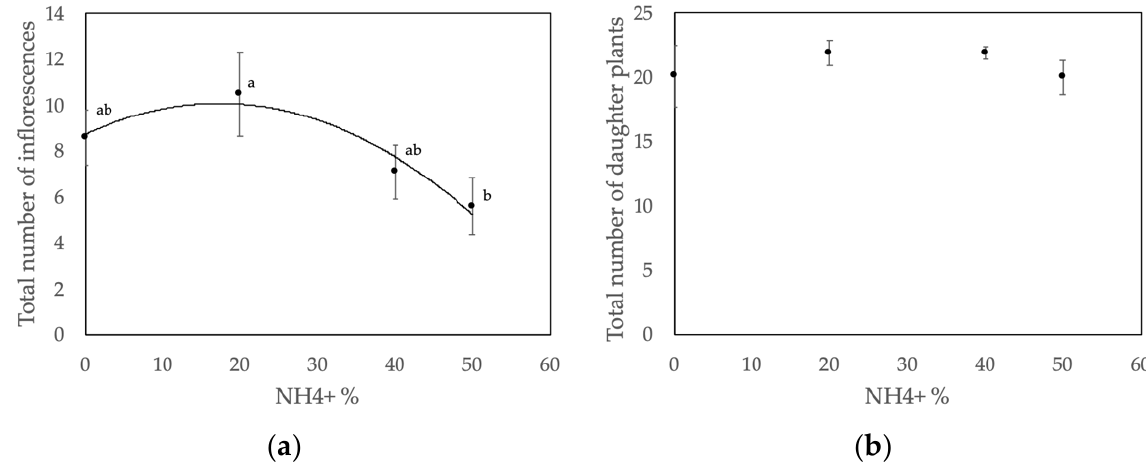
Figure 2. Average number of inflorescences and daughter plants under increasing percentage of NH 4+ (the remainder being NO 3 − ). ( a ) Average number of inflorescences (Infl) produced under increasing percentage of NH 4+ . Shown are the mean and standard error ( n = 10). Data were analyzed with regression analysis and fitted in a quadratic regression line: Infl = 12.16 − 0.09 NH 4 − 0.005 NH 42 ( p -value = 0.05). Letters indicate the mean separation between treatments (Tukey HSD, α = 0.05, p -value = 0.05). ( b ) Average number of daughter plants harvested under increasing percentages of NH 4+ . Shown are the mean and standard error ( n = 10). No significant differences were found.